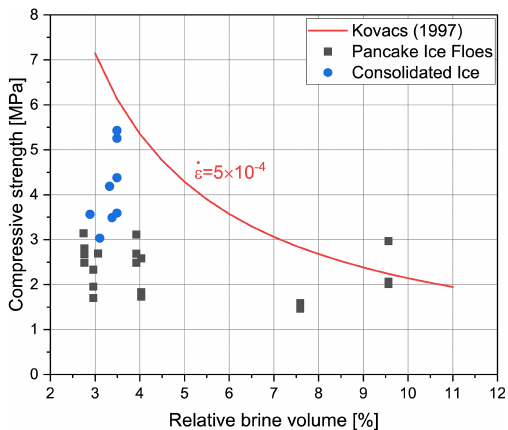
Figure 16. Maximum uniaxial compressive stress for pancake and pack ice over depth with the 90th-percentile confidence intervals indicated.